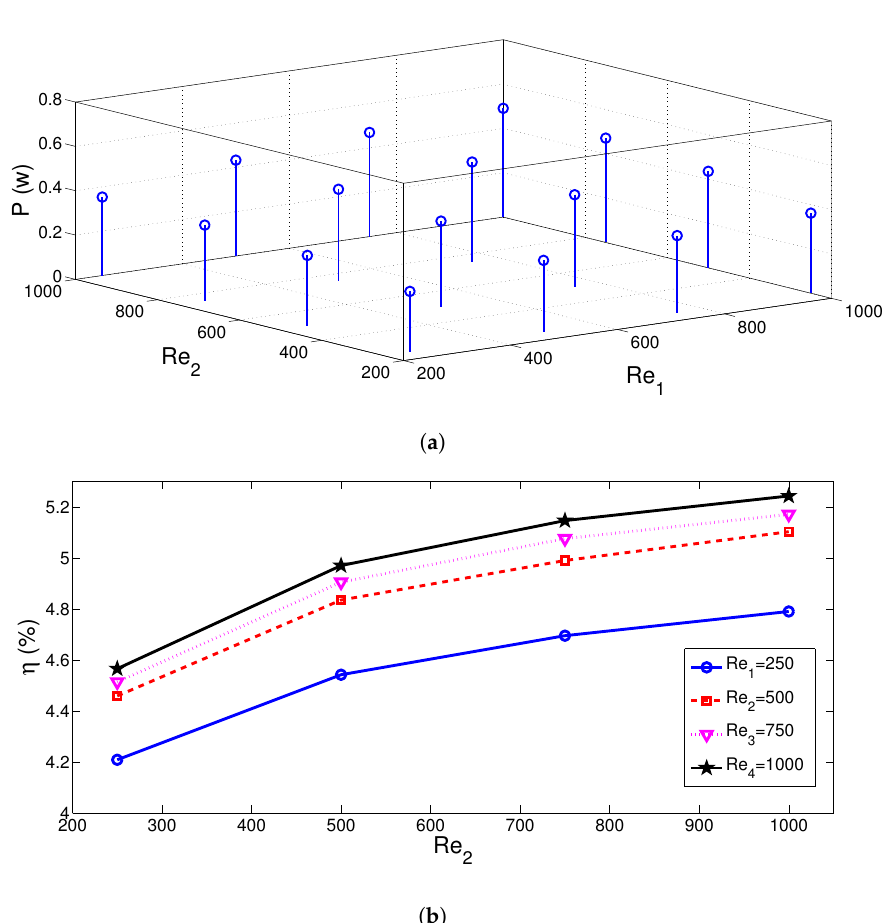
Figure 8. Generated powers ( a ) and efficiencies of the TEG device ( b ) with varying jet stream Reynolds number combinations ((r 1 , r 2 ) = (1, 1), z h = 3w s , φ =